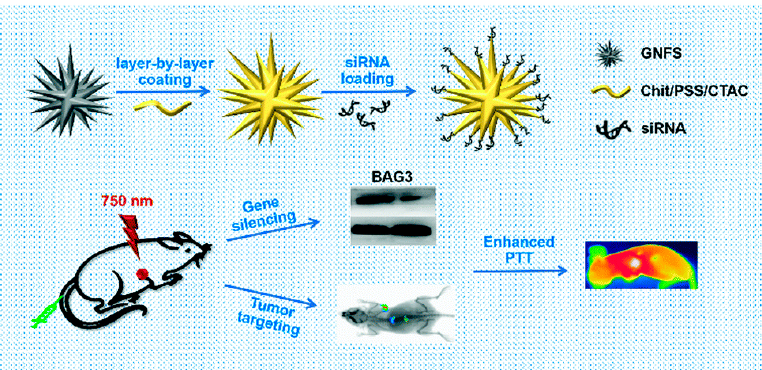
Figure 5. A schematic representation showing the preparation of “GNFs–siRNA” and the treatment process (reprinted with permission from [102]).